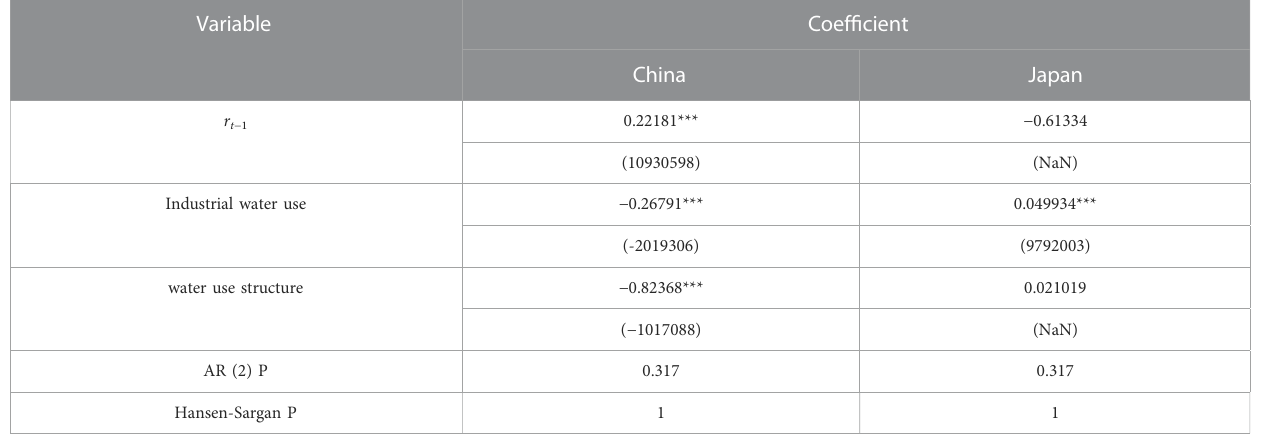
TABLE 5 Relationship between water use and stock market